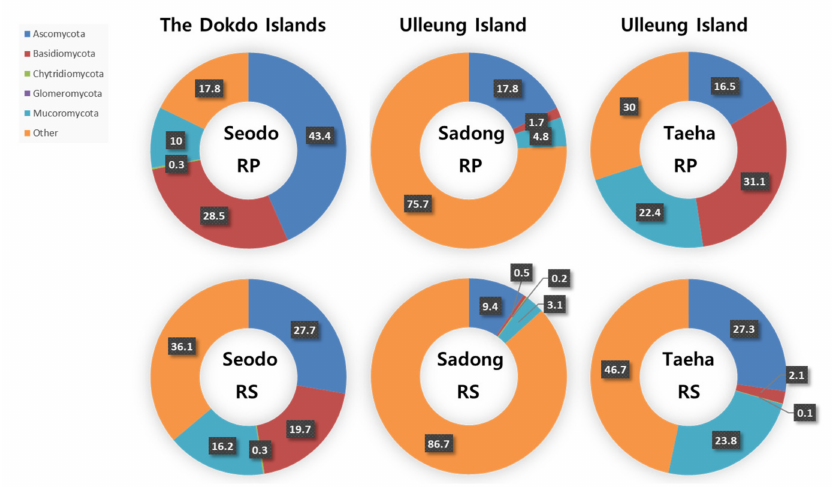
Figure 2. Fungal phyla distribution in the rhizoplane (RP) and rhizosphere (RS) samples (unit: